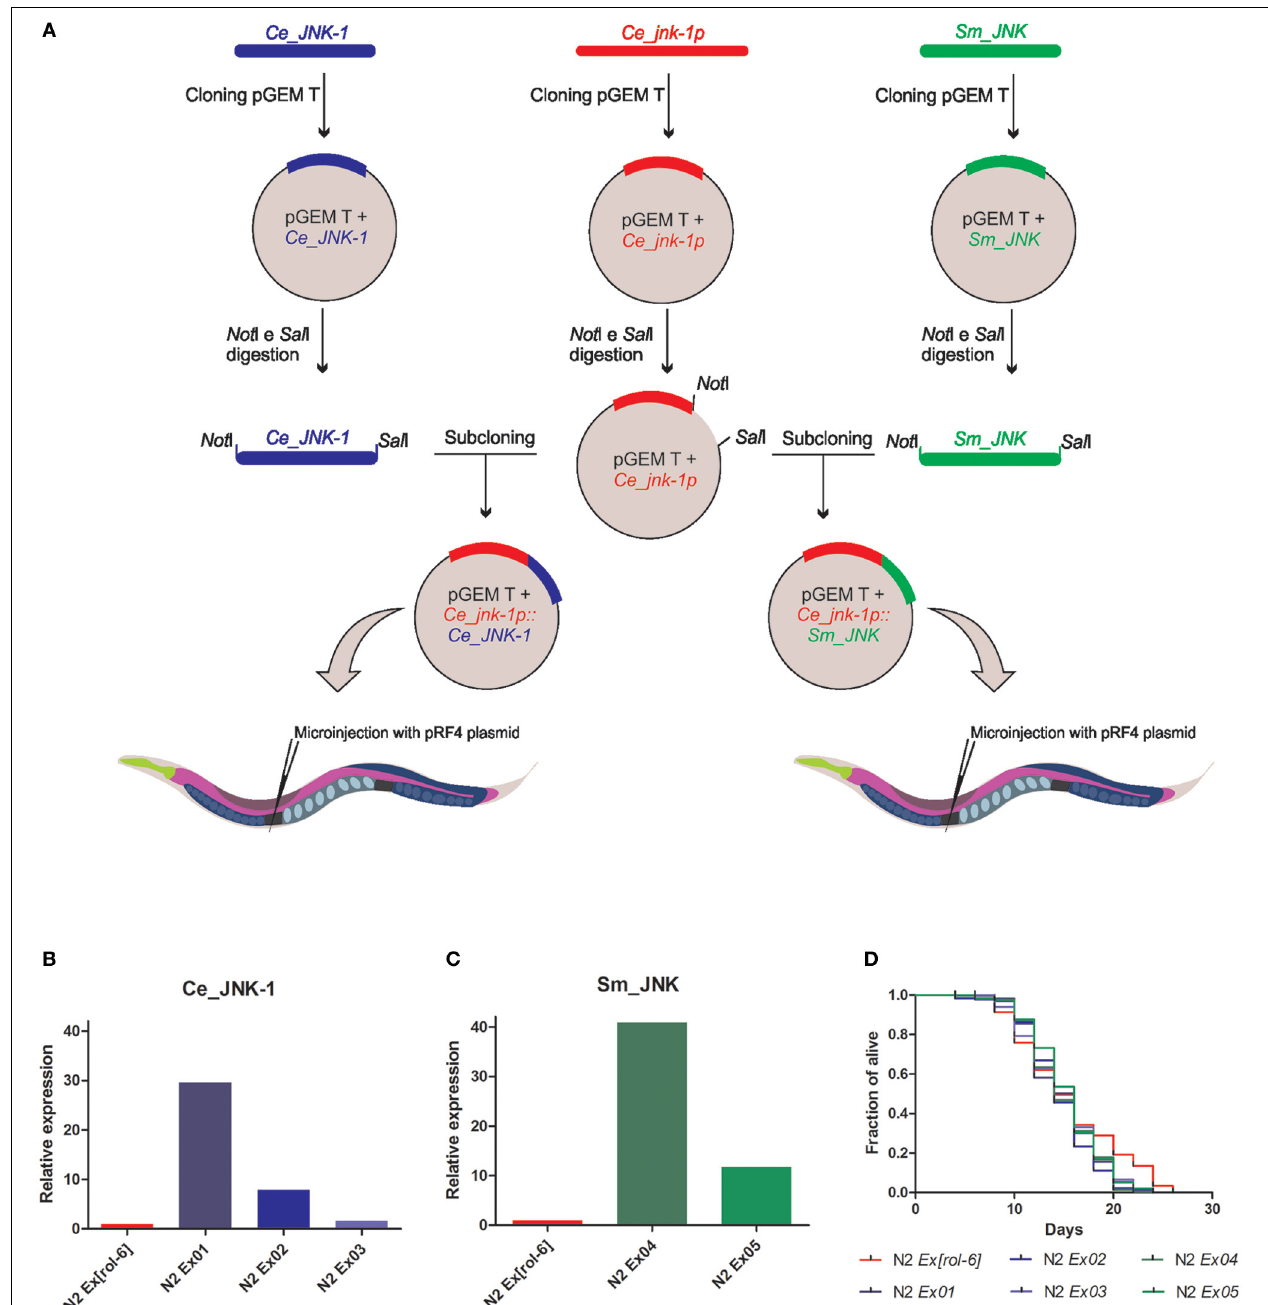
enzymes ( Not I and Sal I) to linearize the vector containing the promoter region and to recover the CDS. Subsequently, subcloning was performed by ligation of C. elegans and S. mansoni CDS with the construct containing the promoter region. The plasmids were injected at 50ng/ µ L into the gonad of young adult N2 worms to generate stable extrachromosomal transgenic lines. mRNA level of Ce_JNK-1 (B) Sm_JNK (C) in wild-type animals. mRNA levels were measured in the transgenic lineages obtained for Ce_JNK-1 (N2 Ex01[Ce_jnk-1p::Ce_JNK-1 ], N2 Ex02[Ce_jnk-1p::Ce_JNK-1] , and